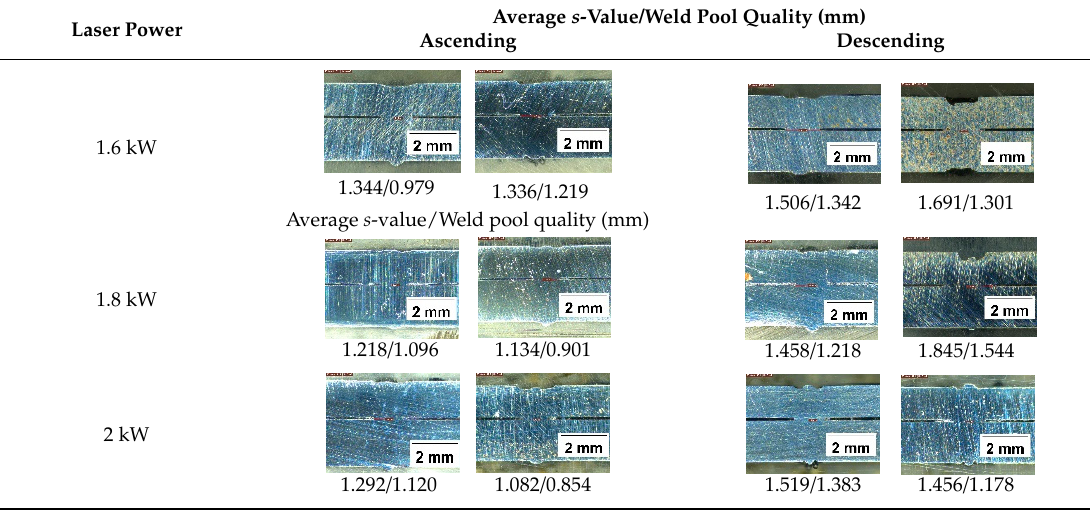
Table 7. The laser welding experimental data for experiment #1 ‐ 2.